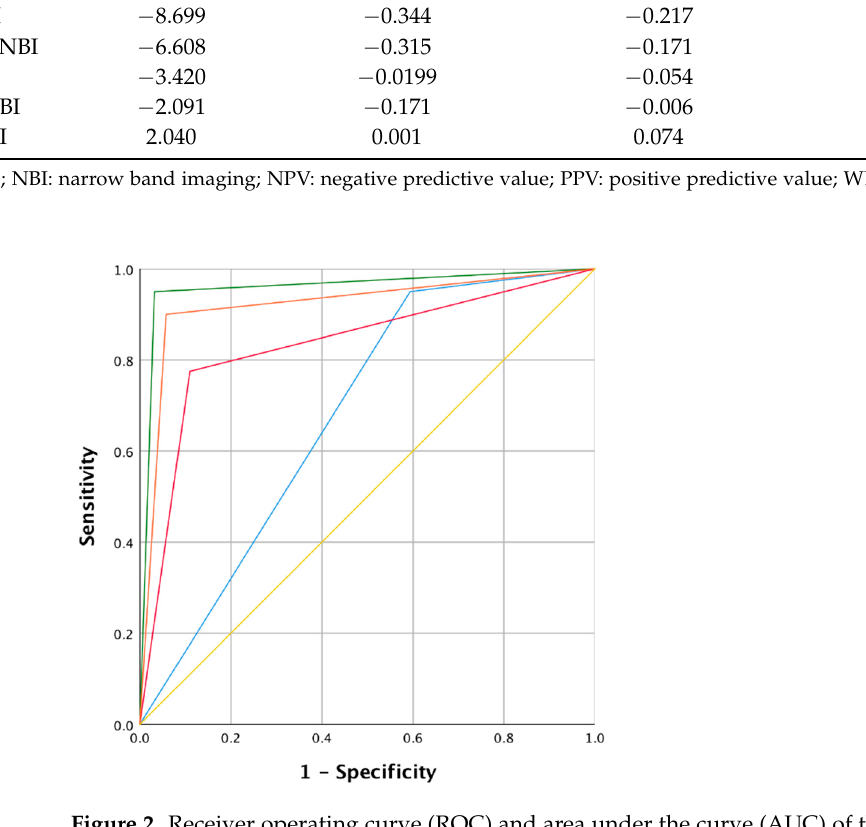
Figure 2. Receiver operating curve (ROC) and area under the curve (AUC) of the four modalities analyzed for group A. Colors of the curves: Green: narrow-band imaging (NBI); Orange: white light endoscopy (WLE) 1 + 2 + NBI; Red: WLE 2; Blue: WLE 1 + 2; Yellow: mean values.